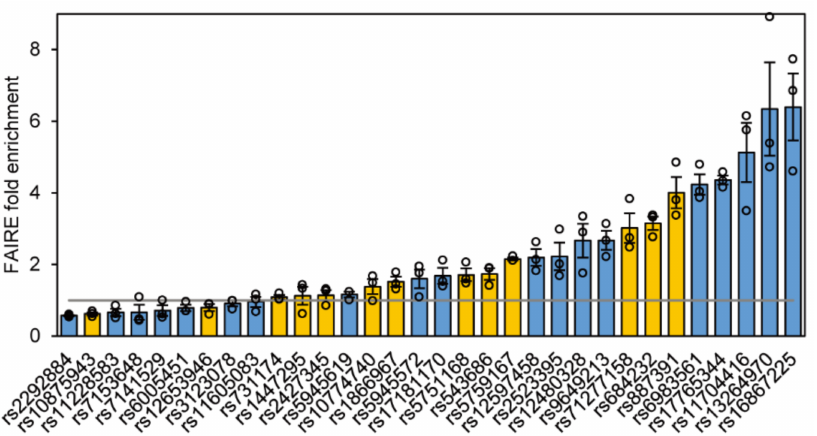
Figure 2. Chromatin status of the 32 functional SNPs in 22Rv1 cells. FAIRE-qPCR analysis of the 32 regulatory SNPs identified by DiR-seq analysis in 22Rv1. Heterozygous SNPs are highlighted in orange. Mean ± SEM of three independent experiments.